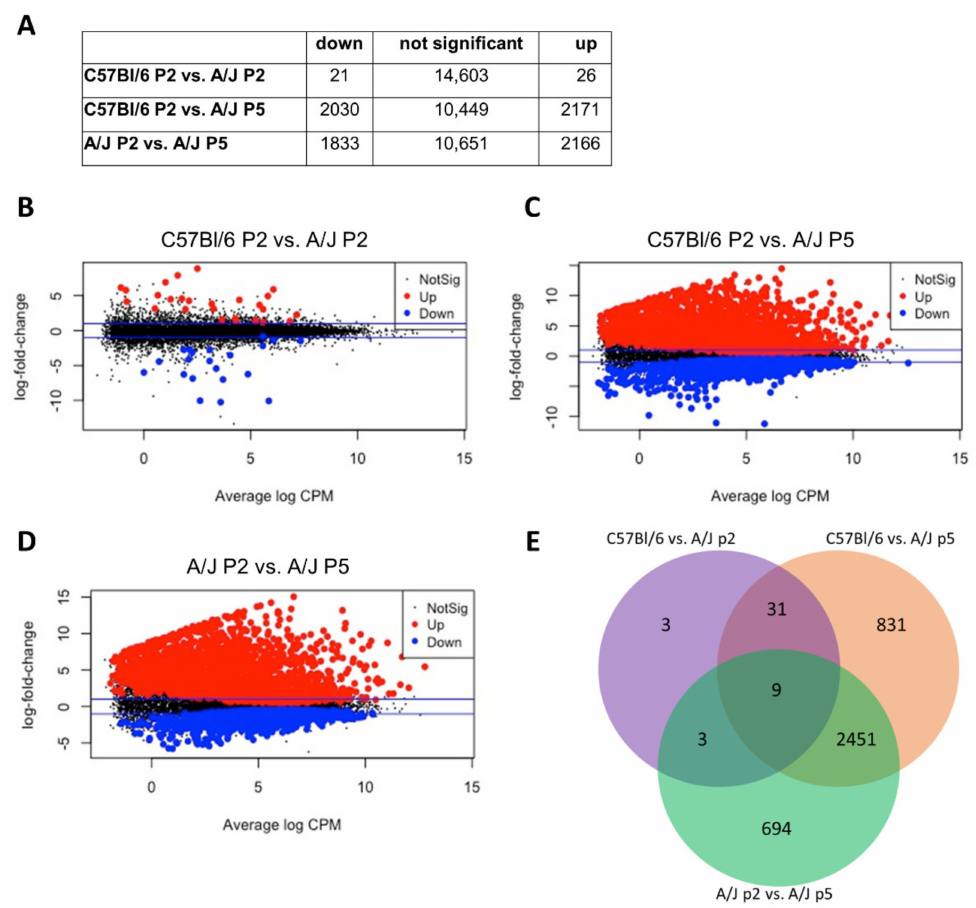
Figure 3. Bulk RNAseq comparison of low (passage 2 C57Bl/6 and A/J) and high (passage 5 A/J) stemness ANPG . ( A ) The differentially expressed genes p -values are corrected for multiple testing error with a 5% FDR (false discovery rate) following quasi-likelihood statistical test. The correc- tion used is Benjamini–Hochberg (BH). The table gives the differentially expressed genes statistics (FDR 5%) and the number of genes with a fold change >2. ( B – D ). Mean difference plots (MD plots) of expression data showing significantly DE genes with a FDR of 5%, highlighted in blue for down and red for up DE genes. The blue line represents the fold change 2 threshold. ( B ) C57Bl/6 P2 vs. A/J P2, ( C ) C57Bl/6 P2 vs. A/J P5 and ( D ) A/J P2 vs. A/J P5. ( E ) Venn diagrams representation of the differentially expressed genes with an FDR < 5% in C57Bl/6 vs. A/J at passage 2 (purple), C57Bl/6 vs. A/J at passage 5 (orange) and A/J at passage 2 vs. A/J at passage 5 (green). Relatively similar gene expression profile are observed between passage 2 A/J and C57Bl/6; however, major changes are observed in passage 5